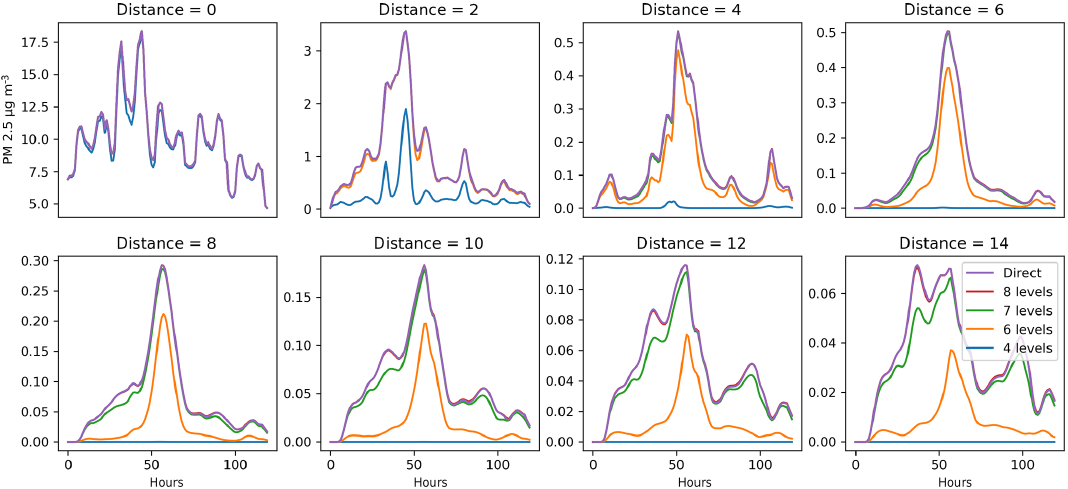
Figure 5. Sensitivity of the concentration of PM 2 . 5 (µgm − 3 ) to the number of vertical levels included in the local region for different distances from the source. The distance from the source is given in numbers of grid cells (one grid cell represents 0.3 ◦ in longitude direction). The source is the Oslo agglomeration. Horizontal axis is time (120h). The results for eight levels cannot be distinguished from the direct method in the figure, even for the largest distance considered.